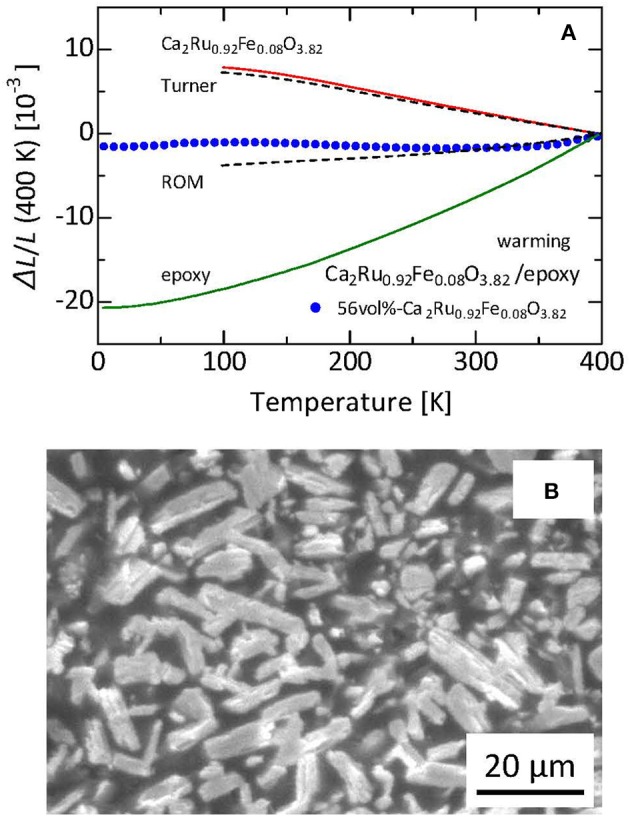
(A) Linear thermal expansion (a) and microscopic image (B) of 56 vol%-Ca2Ru0.92Fe0.08O3.82/epoxy composite. Reference temperature: 400 K. Curves calculated by assuming the ROM and Turner's model are also displayed for comparison. Reproduced from an earlier report (Takenaka et al., 2017b). Copyright (2017) The Japan Society of Applied Physics.